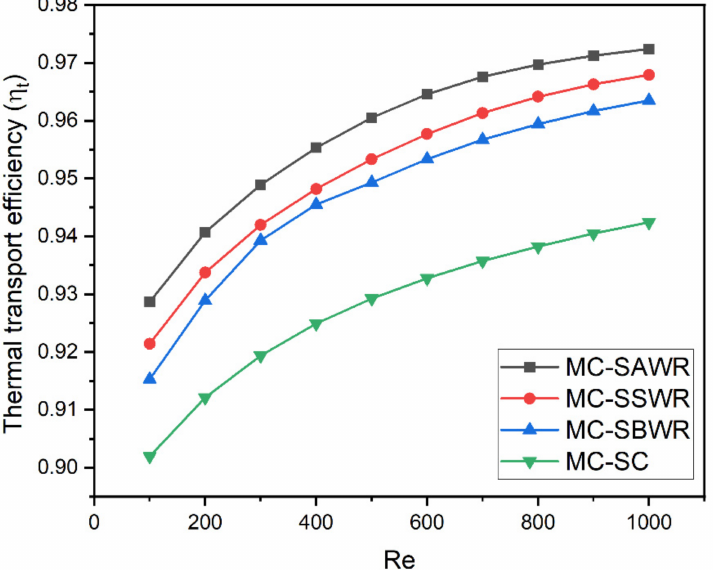
Figure 23. Variation of thermal transport efficiency ( η t ) with Re for various MCHS